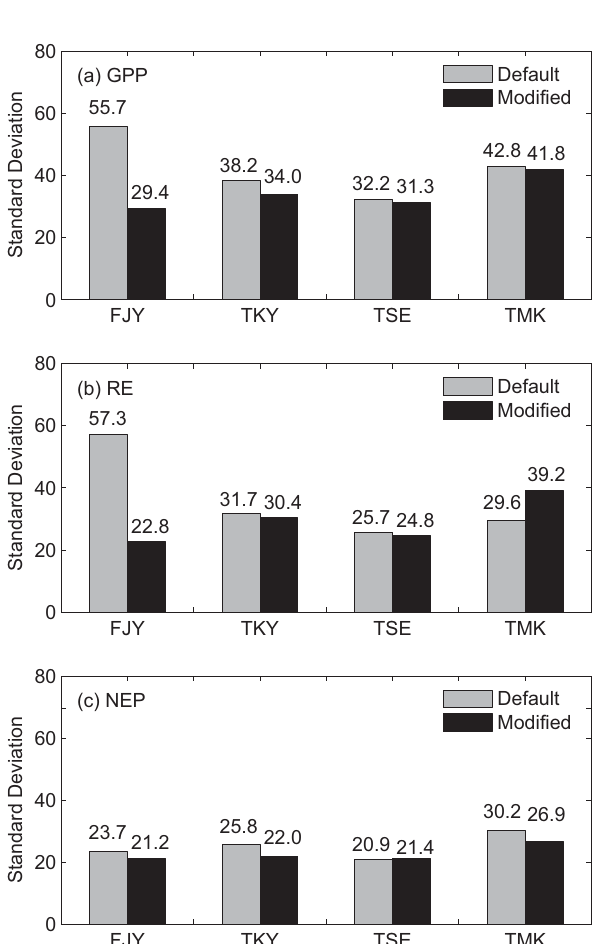
Fig. 5. Average of standard deviations (unit: gCm − 2 month − 1 ) of modeled (a) GPP, (b) RE, and (c) NEP for all models during growing season (April to September). The results from the default (gray) and modified (black) models are shown with numbers.